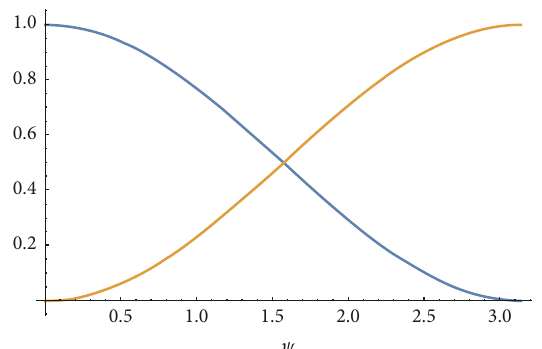
̂Φ ̂Φ /𝑀 /𝑀 + 0 (blue) and − 0 (orange) as functions